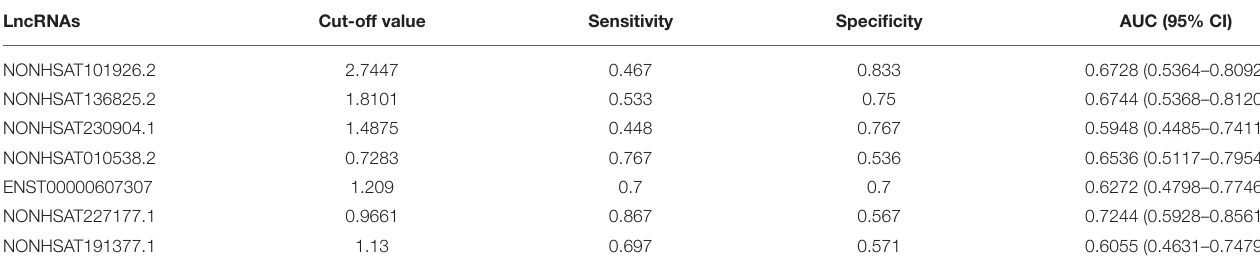
TABLE 7 | Receiver operating characteristic (ROC) analysis of 7 lncRNAs to determine effectiveness in diagnosing